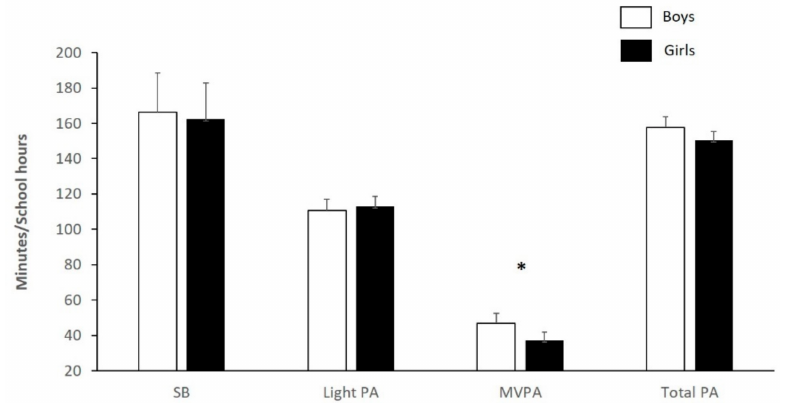
Figure 1. Physical activity and sedentary behaviour during school hours based on gender. SB, sedentary behaviour; light PA, light physical activity; MVPA, moderate to vigorous physical activity; total PA: light, MVPA. * p < 0.05 between boys and